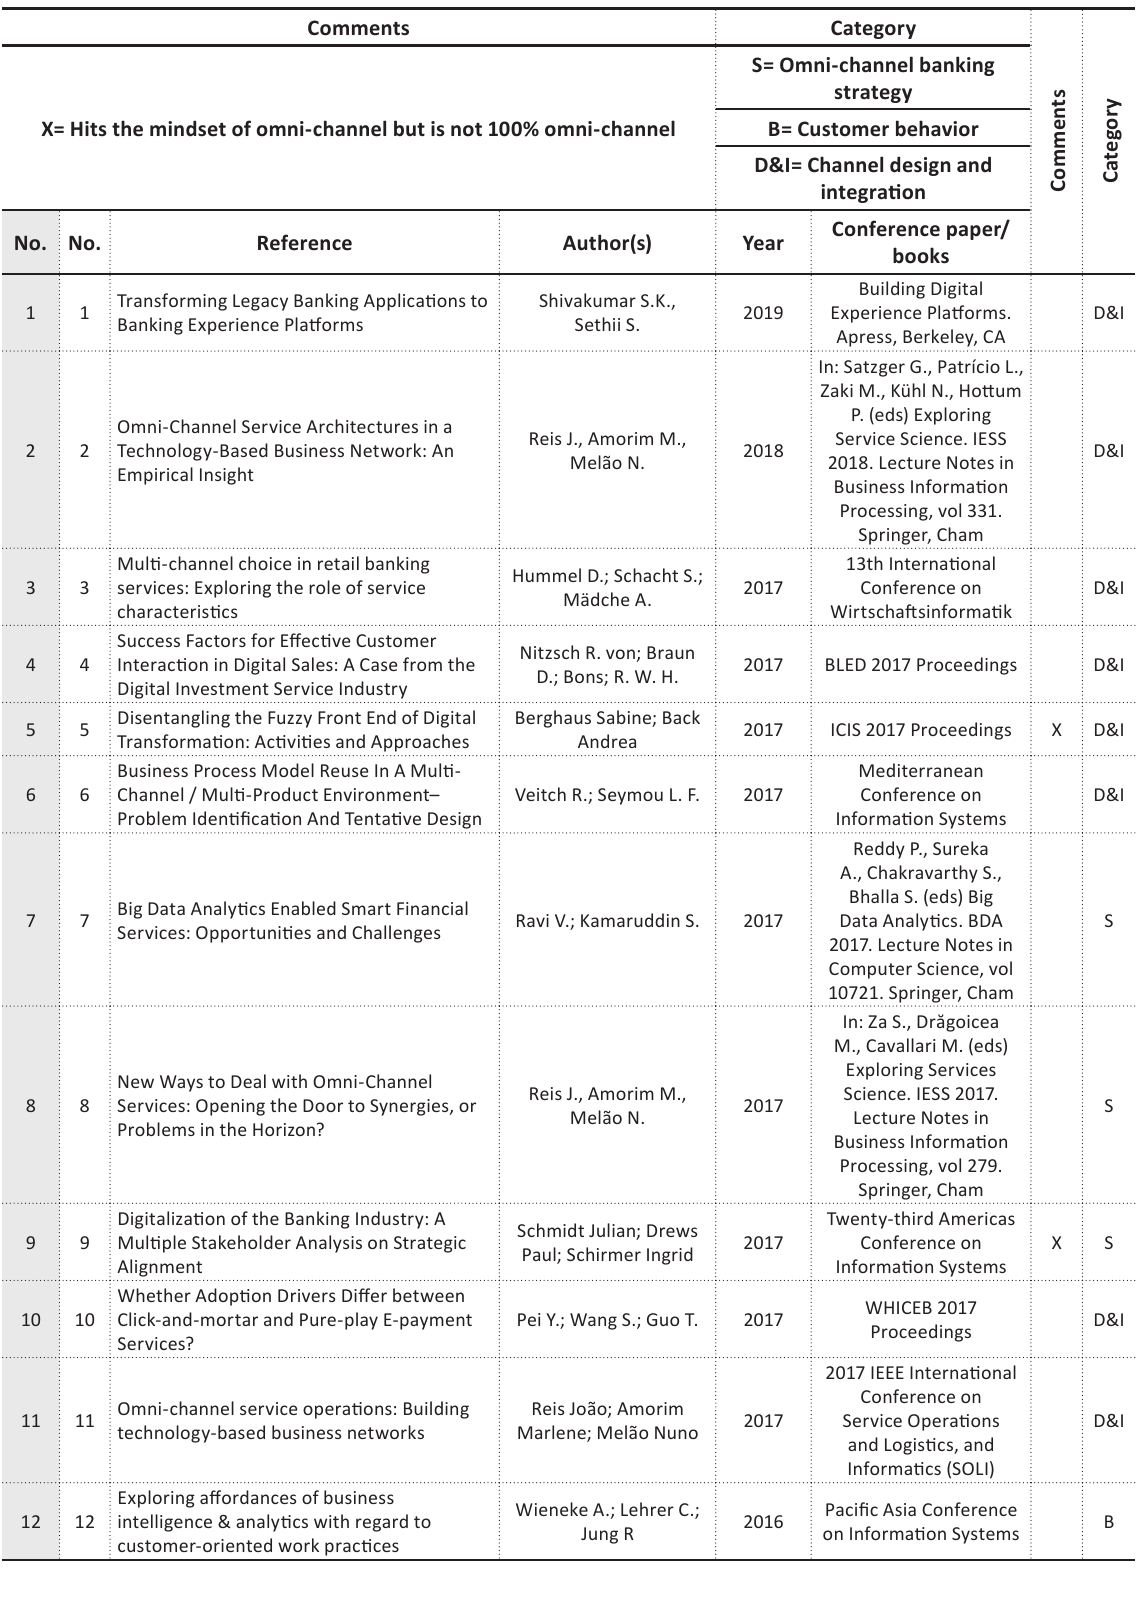
Table A1. Omni-channel in the context of banking literature, search phases 3.1,